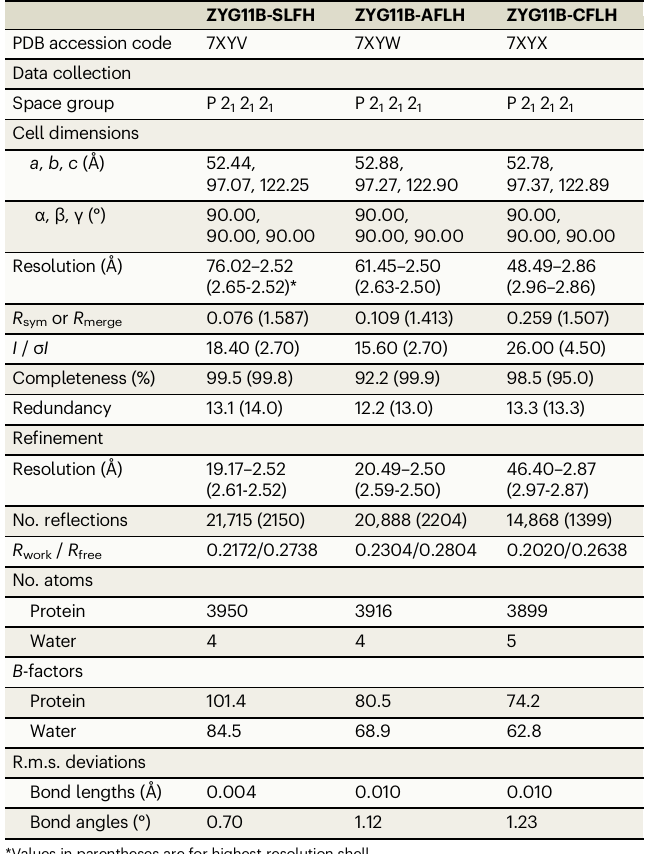
Table 1 | Data collection and re fi nement statistics of ZER1 Table 2 | Data collection and re fi nement statistics of ZYG11B